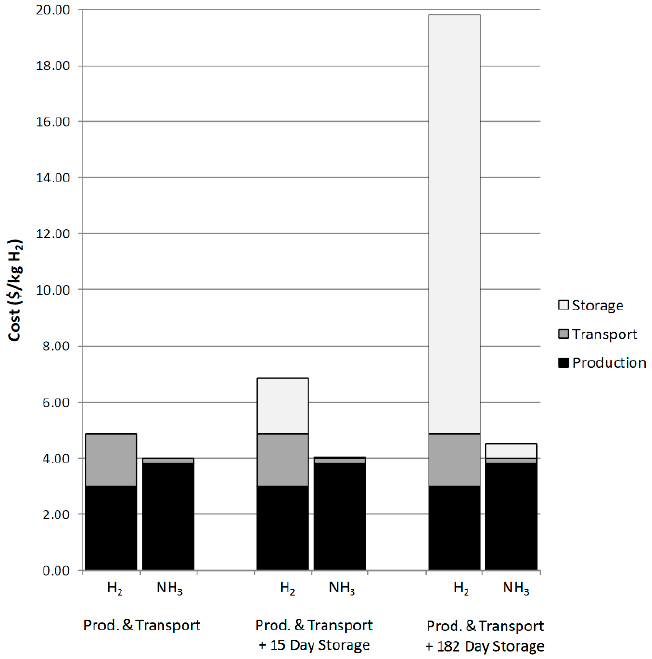
Figure 16. Comparison of production, transportation, and storage costs of hydrogen and ammonia.